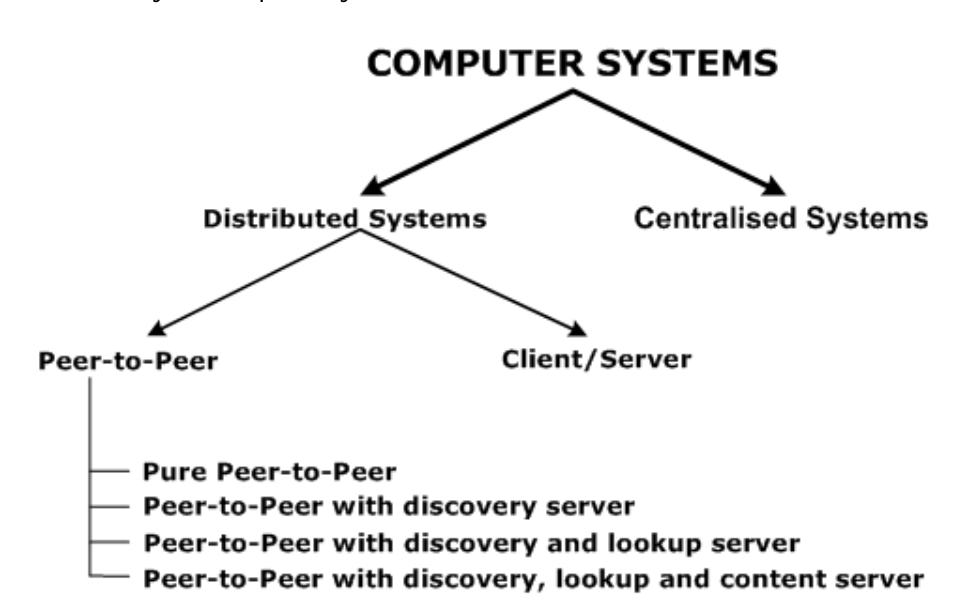
Figure 2 Taxonomy of computer